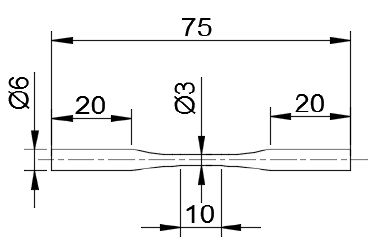
Figure 1. Specimen geometry (mm).